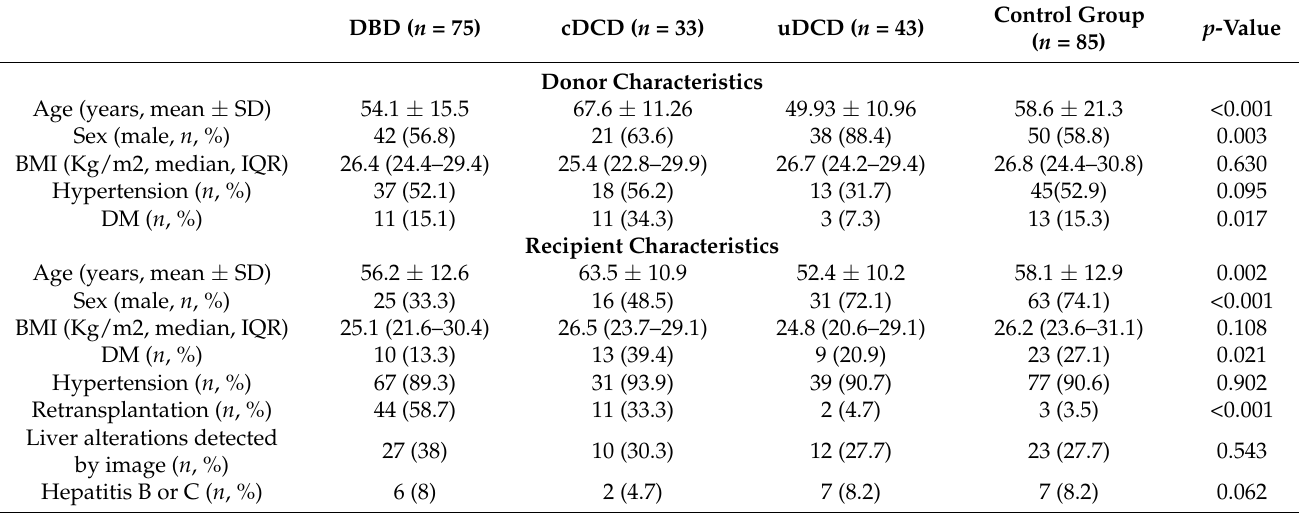
Table 1. Baseline characteristics of donors and recipients. Comparisons between groups were made with ANOVA or Kruskal-Wallis H tests according to its normal or non-parametric distribution (quantitative variables), and with Chi-Square test (categorical